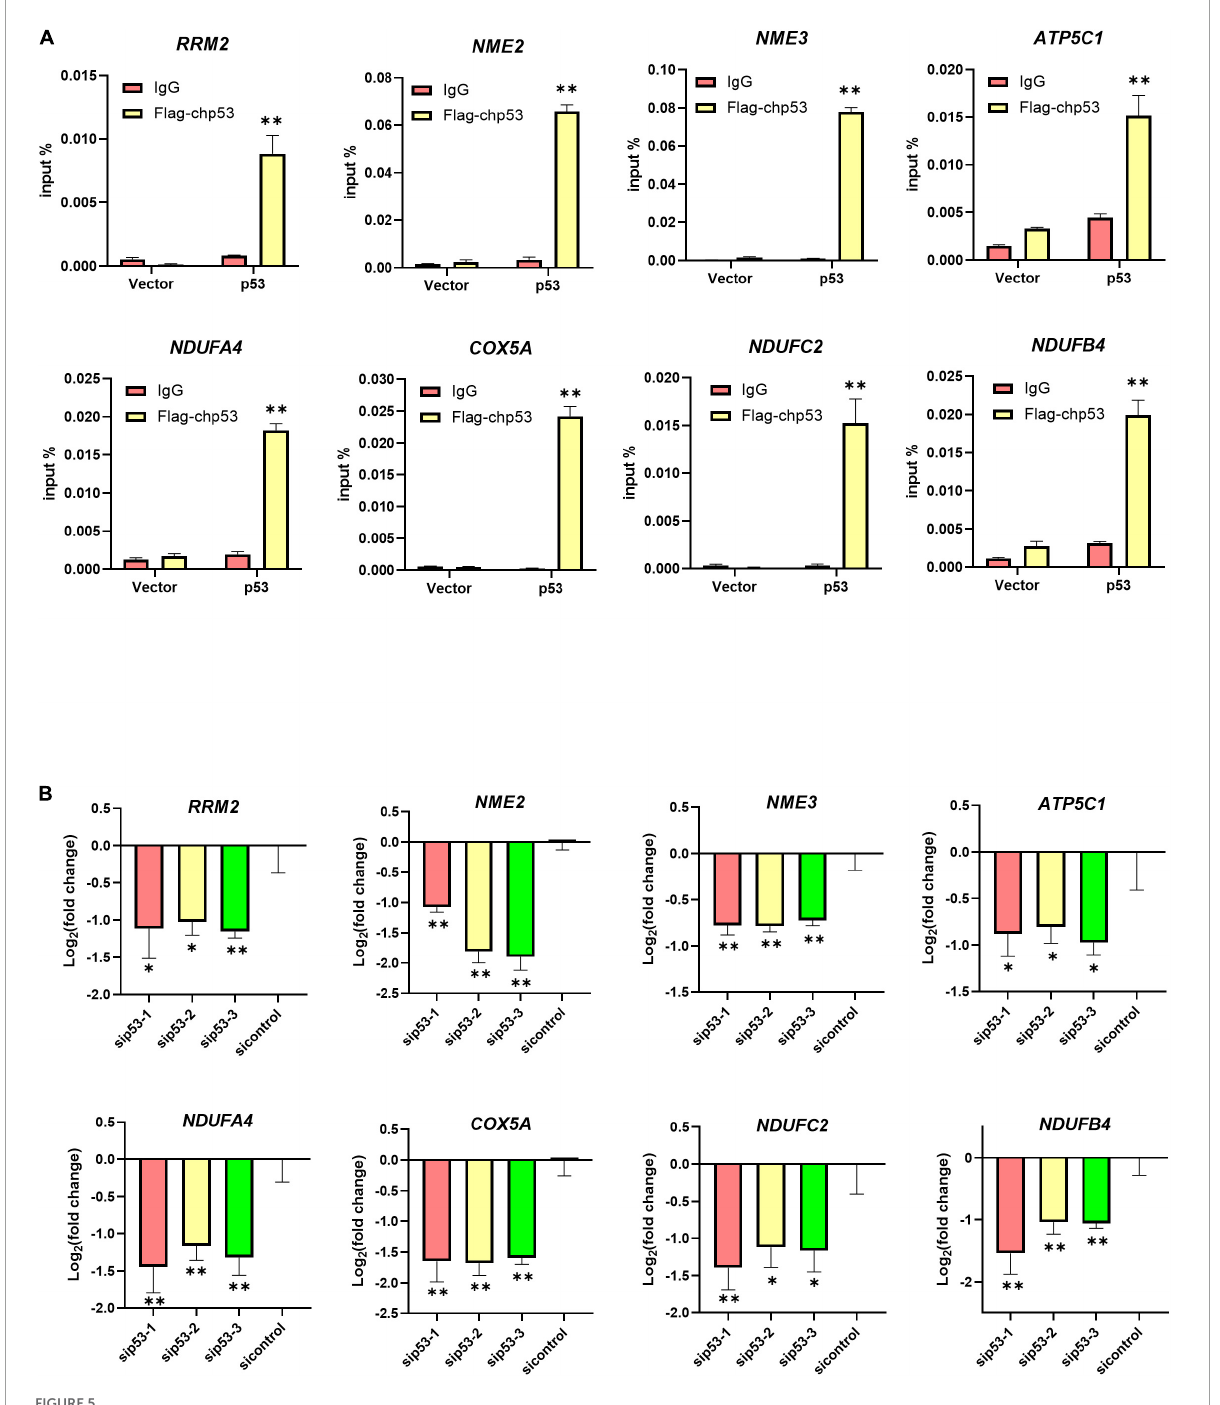
FIGURE5 Identification bona fide direct target genes of p53. (A) LMH cells were transiently transfected with Flag-chp53 or empty vector p3xFLAG-CMV-7.1 plasmid (vector) and harvested at 24 h. ChIP-qPCR analysis of the relative p53 occupancy in the promoters of eight putative chicken p53 direct target genes including RRM2 , NME2 , NME3, ATP5C1 , NDUFA4 , COX5A , NDUFC2, and NDUFB4 in LMH cells. (B) LMH cells were transiently transfected with p53 siRNA (sip53) or negative control siRNA (sicontrol) for 24 h and harvested. The transcriptional levels of eight putative chicken p53 direct target genes including three nucleotide metabolism related genes and five ATP synthesis related genes were detected by RT-qPCR in LMH cells. The results are presented as the mean ± SD, n = 3. * p < 0.05 and ** p < 0.01 indicated the levels of